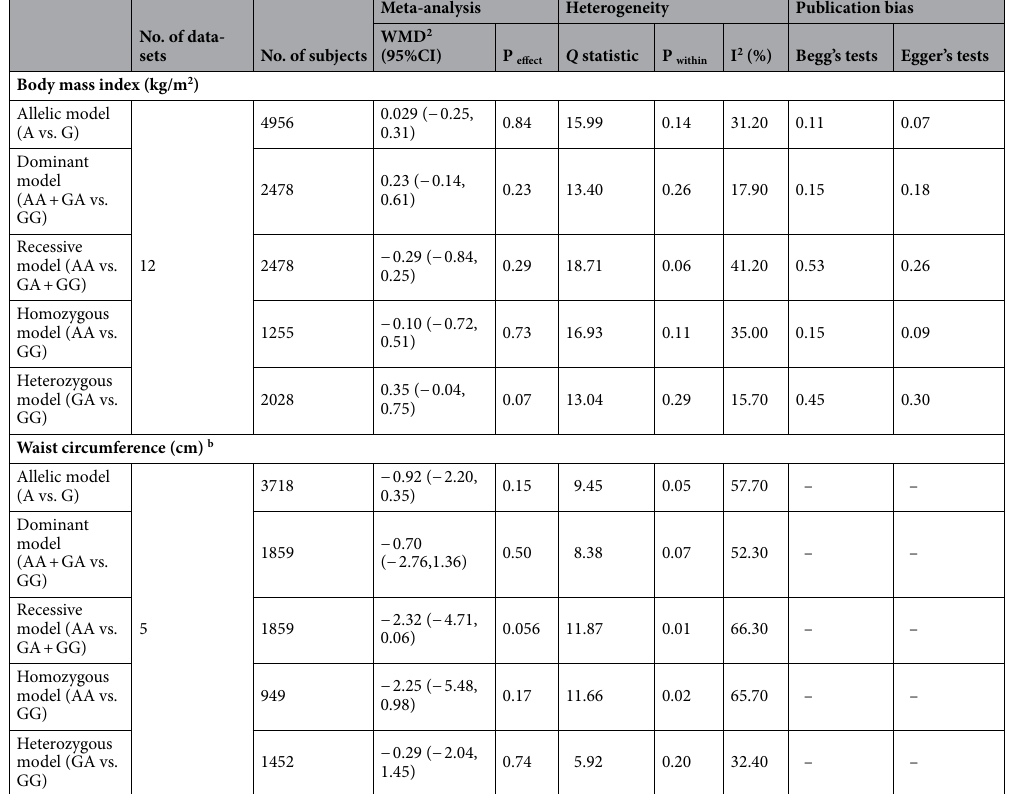
Table 2. The association between CD36 rs1761667 polymorphism and anthropometric indices. All analyses were conducted using a random-effects model a . a All analyses were done using the random-effects model. b There was no evidence of publication bias by observing the funnel plots. WMD, weighted mean